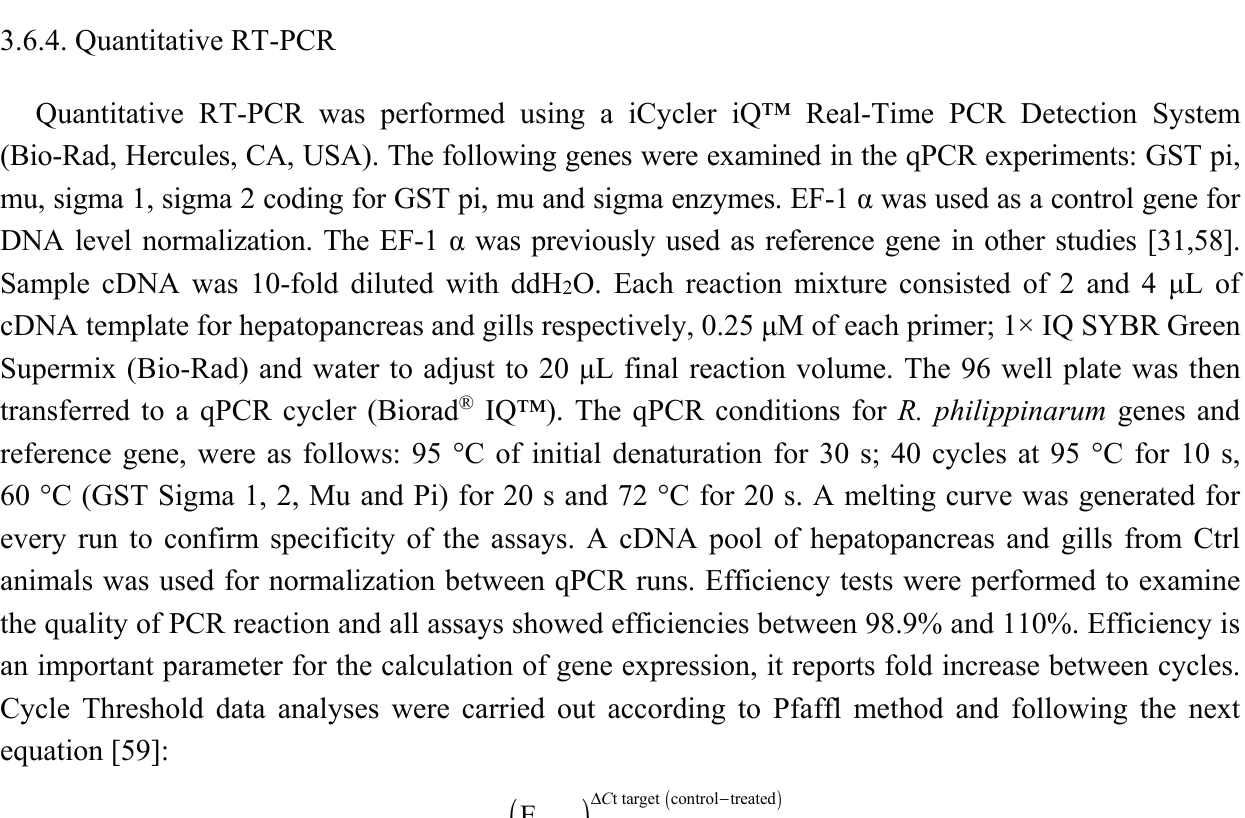
Table 1. Primer pair sequences and product length. Genes quantified through Real-Time PCR. GST Gene